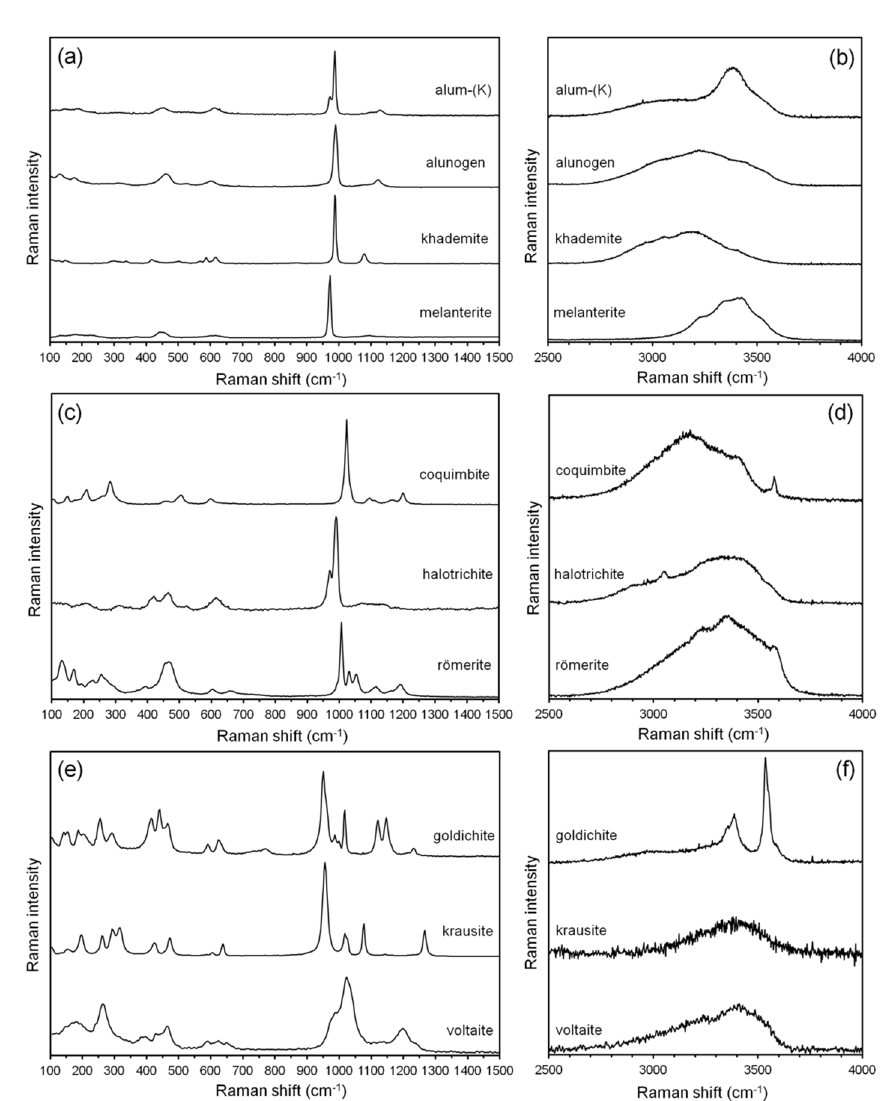
Figure 4. Raman spectra of the studied sulfates in the region between 100 and 1500 cm − 1 and between 2500 and 4000 cm − 1 . ( a , b ) Alum-(K), alunogen, khademite, and melanterite; ( c , d ) coquimbite, halotrichite, and römerite; ( e , f ) goldichite, krausite, and voltaite. Table 3. Raman bands (in cm − 1 ) and their assignments for the studied